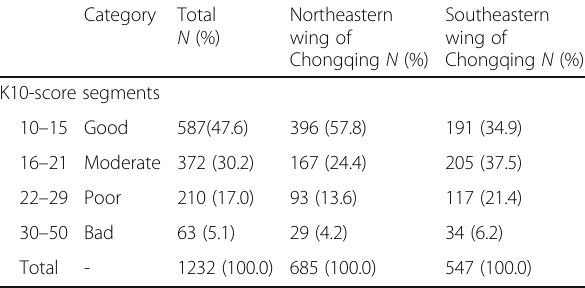
Table 2 Mental health of the elderly in poverty state counties of Chongqing Category Total N (%)